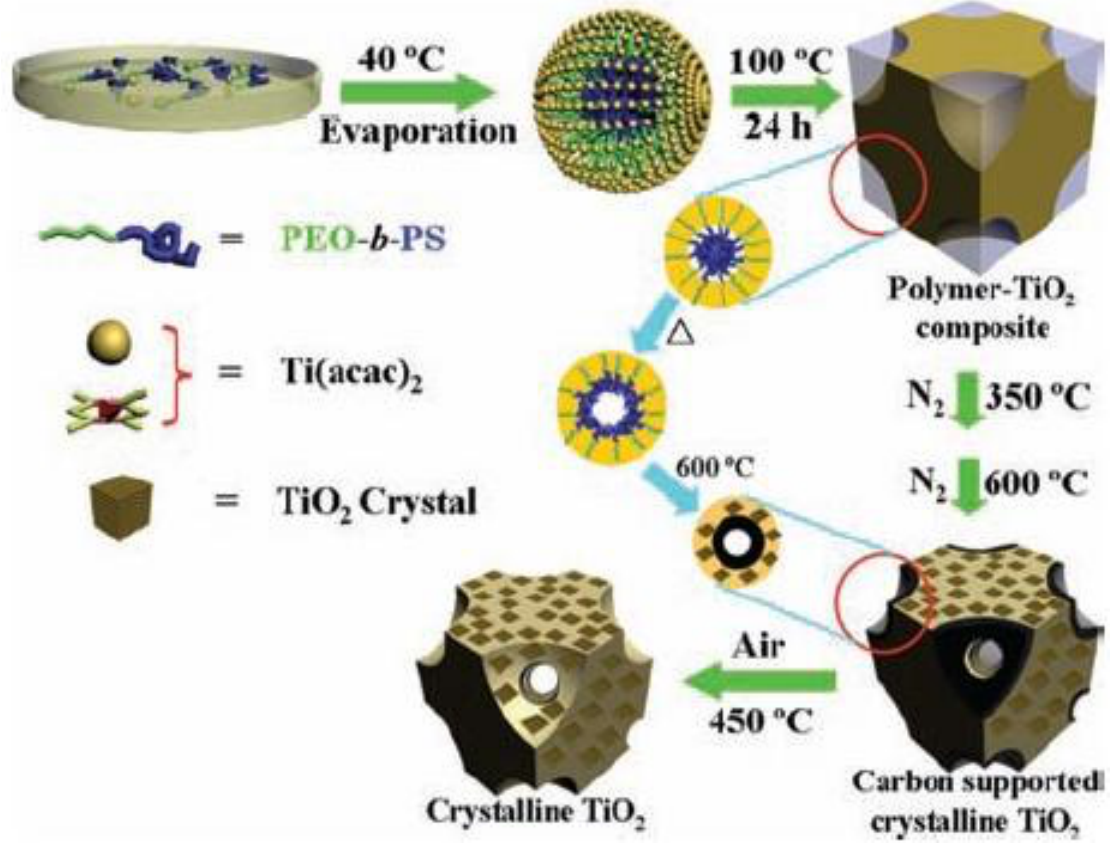
Figure 7. Scheme showing the positive effects of multistep heat treatment in forming large-pore mesoporous TiO materials. Reprinted with permission from [87]. Copyright 2 2011 John Wiley and